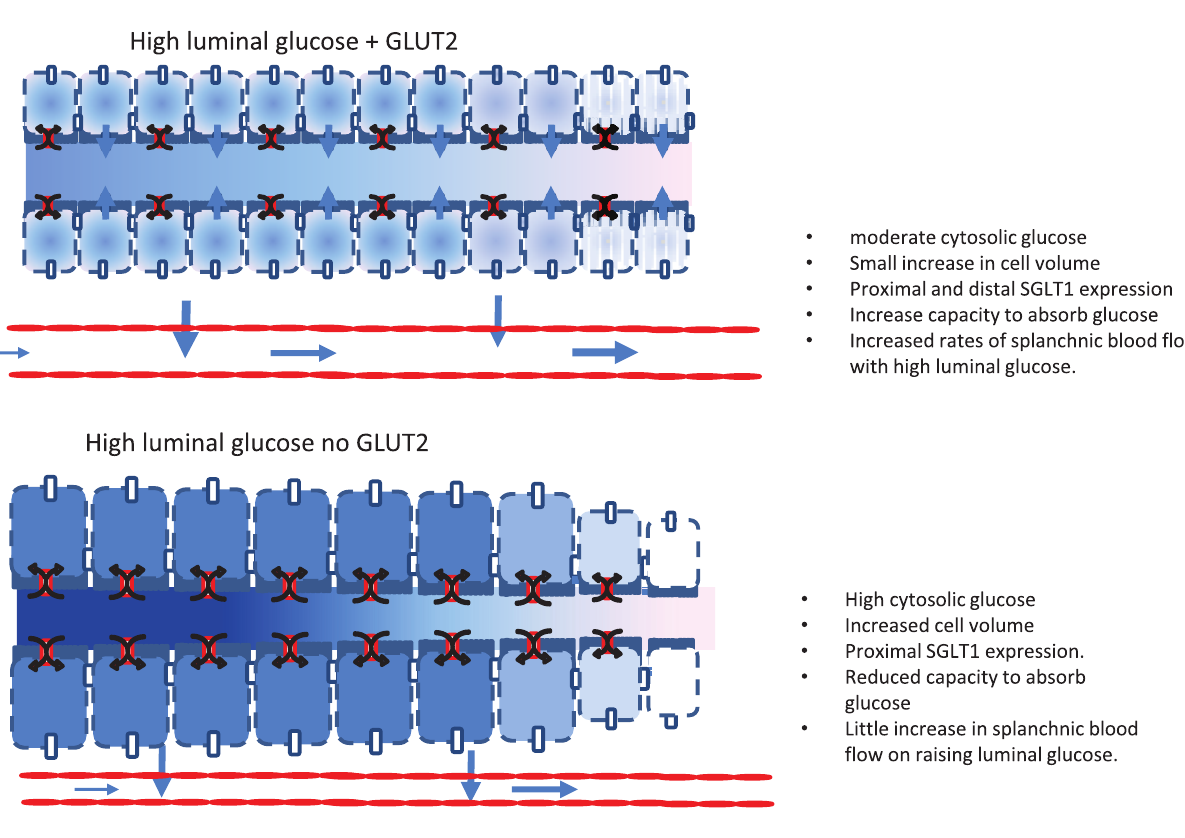
Figure 5. Diagram showing the predicted effects from the simulation model of loading enterocytes with luminal fluid containing 50 mM glucose and 5 mM glucose in the capillary perfusion fluid in A normal enterocytes expressing apical membrane GLUT2 and in B GLUT2 KO enterocytes. The KO cells have higher enterocyte glucose concentrations in the proximal intestine, but higher paracellular flow and larger cell volumes. The normal enterocytes have lower cytosolic glucose concentrations and SGLT1 is more widely dispersed along the intestinal length with higher rates of glucose permeation in distal regions of the small intestine. Long term exposure may lead to higher maximal glucose absorption rates in normal intestine than with GLUT2